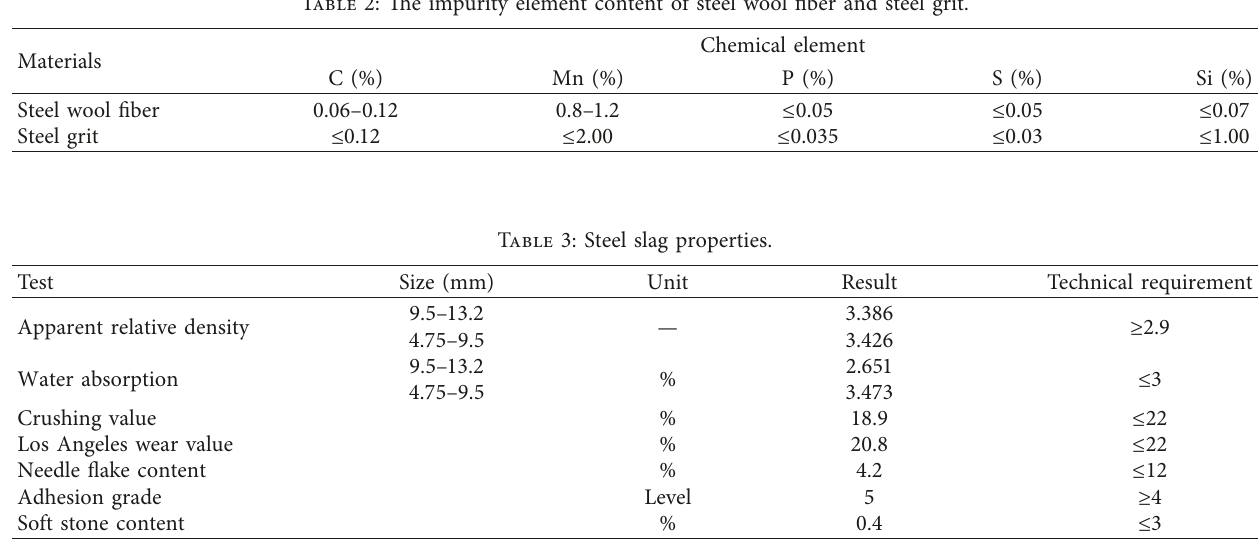
Figure 6, was divided into two parts: induction temperature